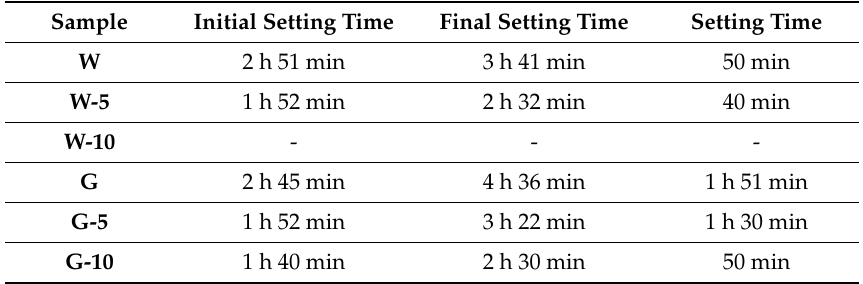
Table 2. Setting